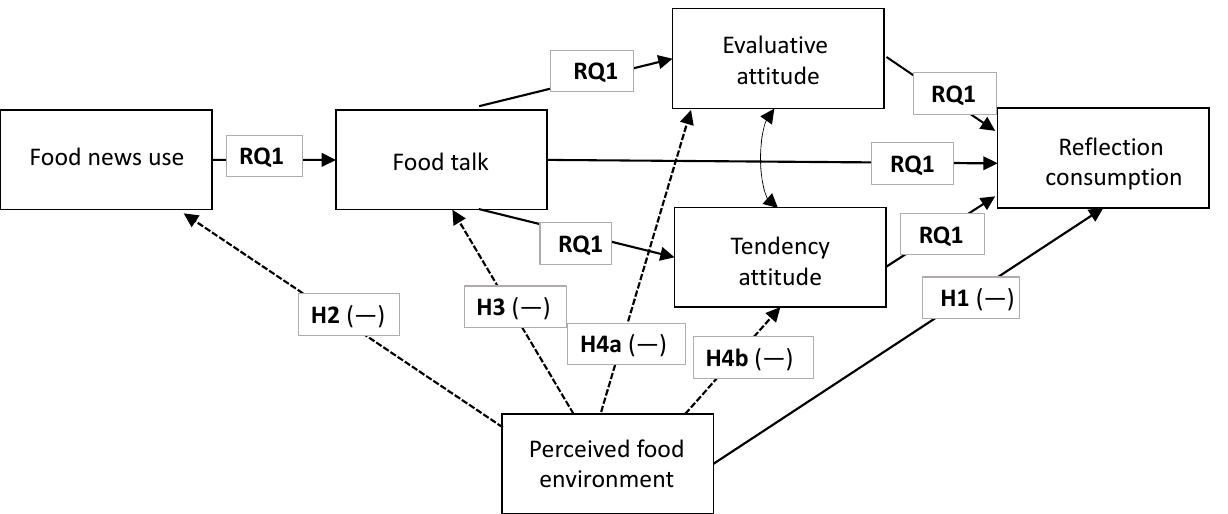
Figure 1. Hypotheses and research questions proposed. Note: The RQ1 corresponds to the CMM testing. Dotted lines represent this paper’s main